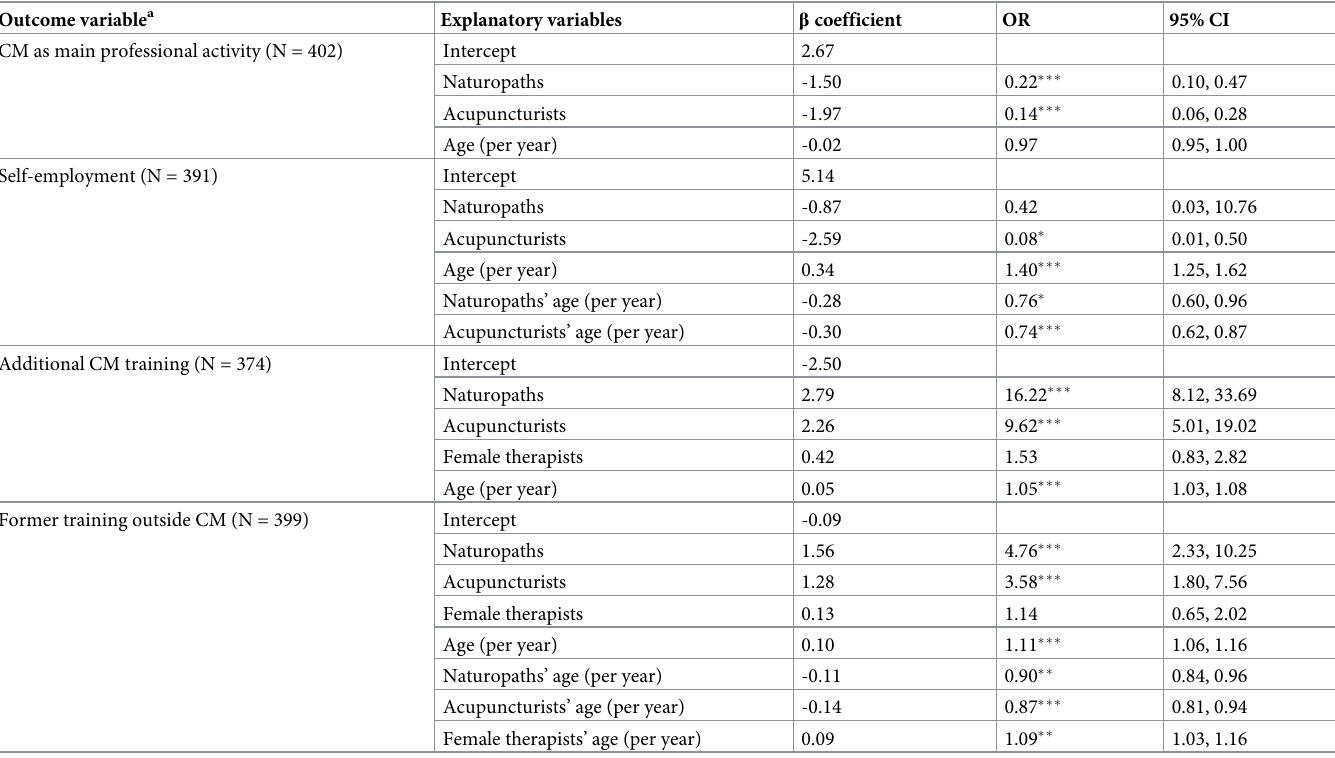
Table 7. Determinants of working conditions and CM training. Multivariate analysis (logistic regressions). Outcome variable